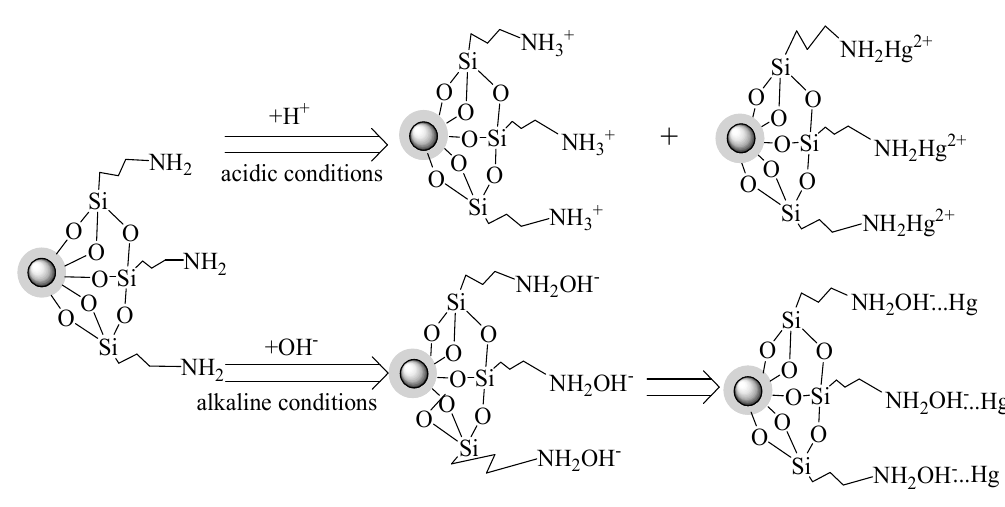
Figure 16. ( a ) XPS spectra of wide scan; ( b ) Hg 4 f after adsorption; ( c ) N 1 s spectra of CoFe 2 O 4 @SiO 2 – NH 2 nanoparticles before; ( d ) and after adsorption.